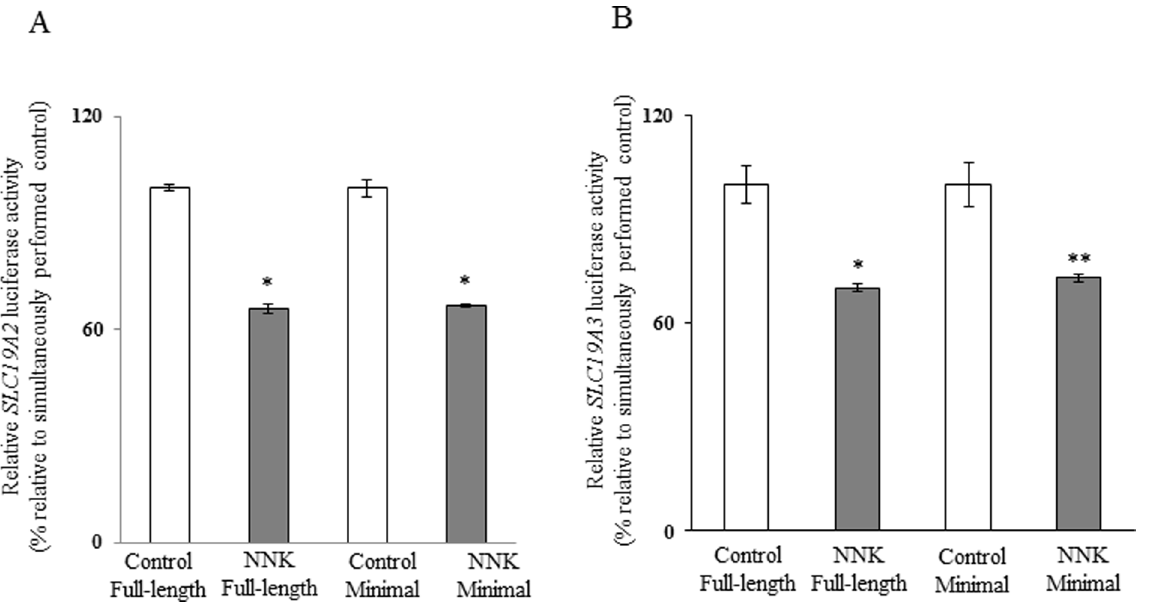
Figure 9. Role of the minimal regions of the SLC19A2 and SLC19A3 promoters in mediating the NNK effect. Full-length and minimal SLC19A2 (A) and SLC19A3 (B) promoters in pGL3-Basic were transiently transfected in 266-6 pancreatic acinar cells; luciferase assays were performed as described under ‘‘Materials and Methods’’. Data are reported as relative firefly luciferase activity normalized to Renilla luciferase activity and represent mean 6 SE of at least three independent experiments. * P , 0.01, ** P , 0.05.